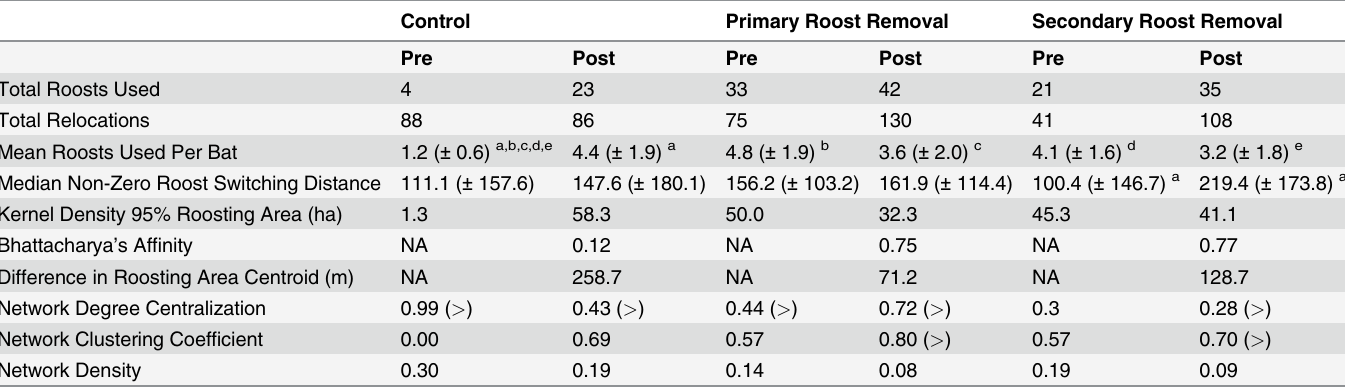
Table 1. Summary of female northern long-eared bat roost use patterns.